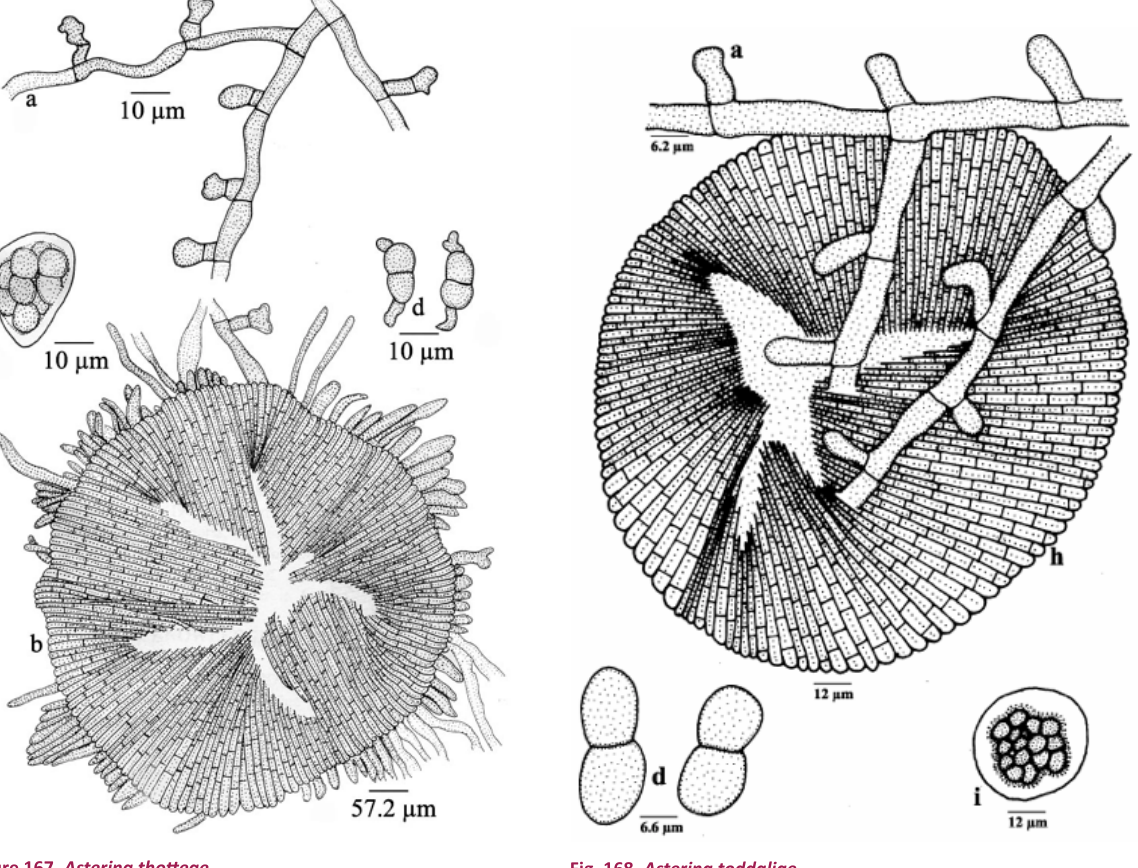
Figure 167. Asterina thotteae a.Appressorium, b. Thyriothecium, c. Ascus, d. Ascospores